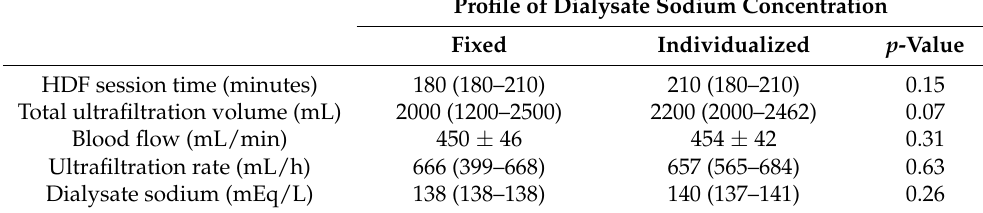
Table 1. Characteristics of two hemodiafiltration sessions with different profile of dialysate sodium concentration applied in 13 patients. The results are reported as mean ± standard deviation or median (percentile 25–percentile